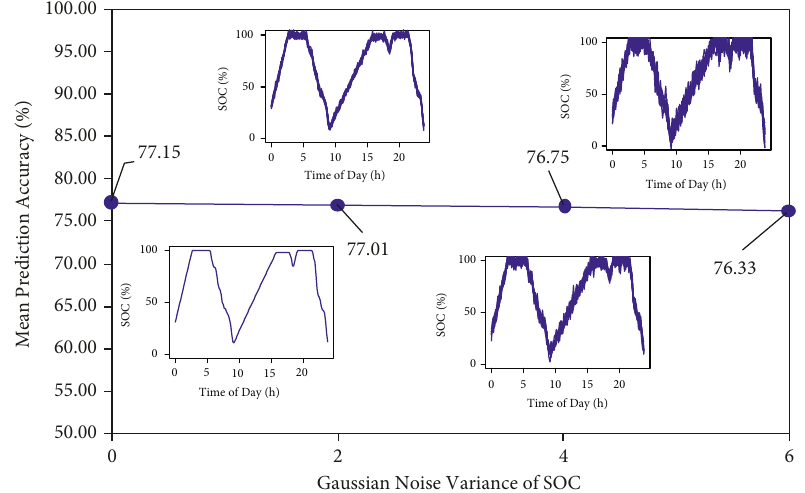
Figure 11: The prediction accuracy under different Gaussian noise variances of SOC.